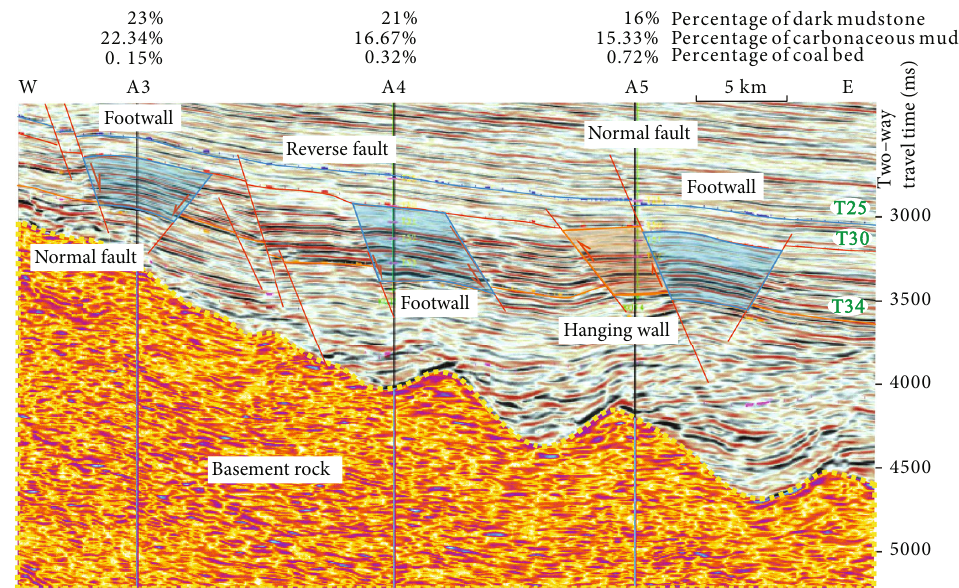
Figure 11: Control of faults on coal-measure source